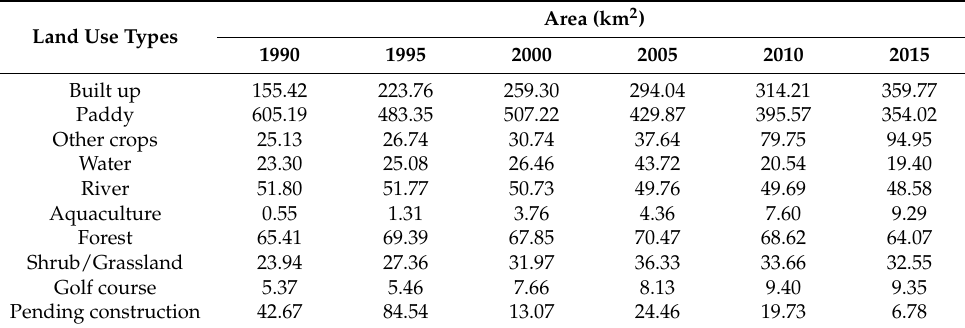
Table 4. Area of land use types in Yangon from 1990 to